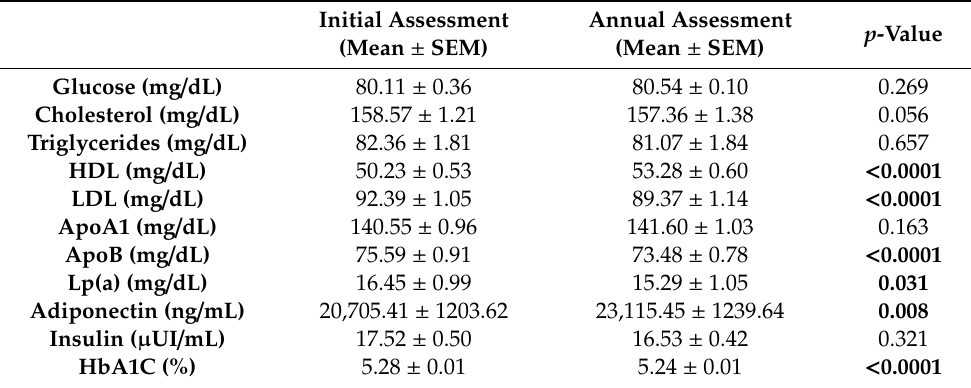
Table 5. Biochemical and endocrinologic parameters in subjects with obesity.